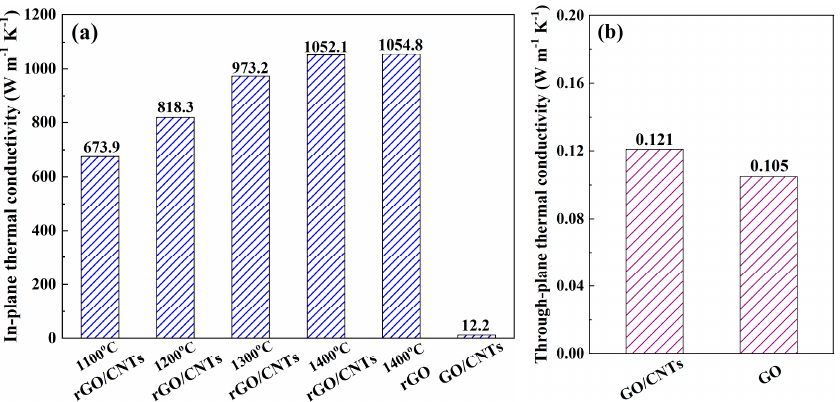
Figure 5. ( a ) In-plane thermal conductivity of the rGO/CNT composite films with different annealing temperatures compared with that of the rGO film after annealing at 1400 °C; ( b ) through-plane thermal conductivity of the GO/CNT composite film compared with that of the GO film.